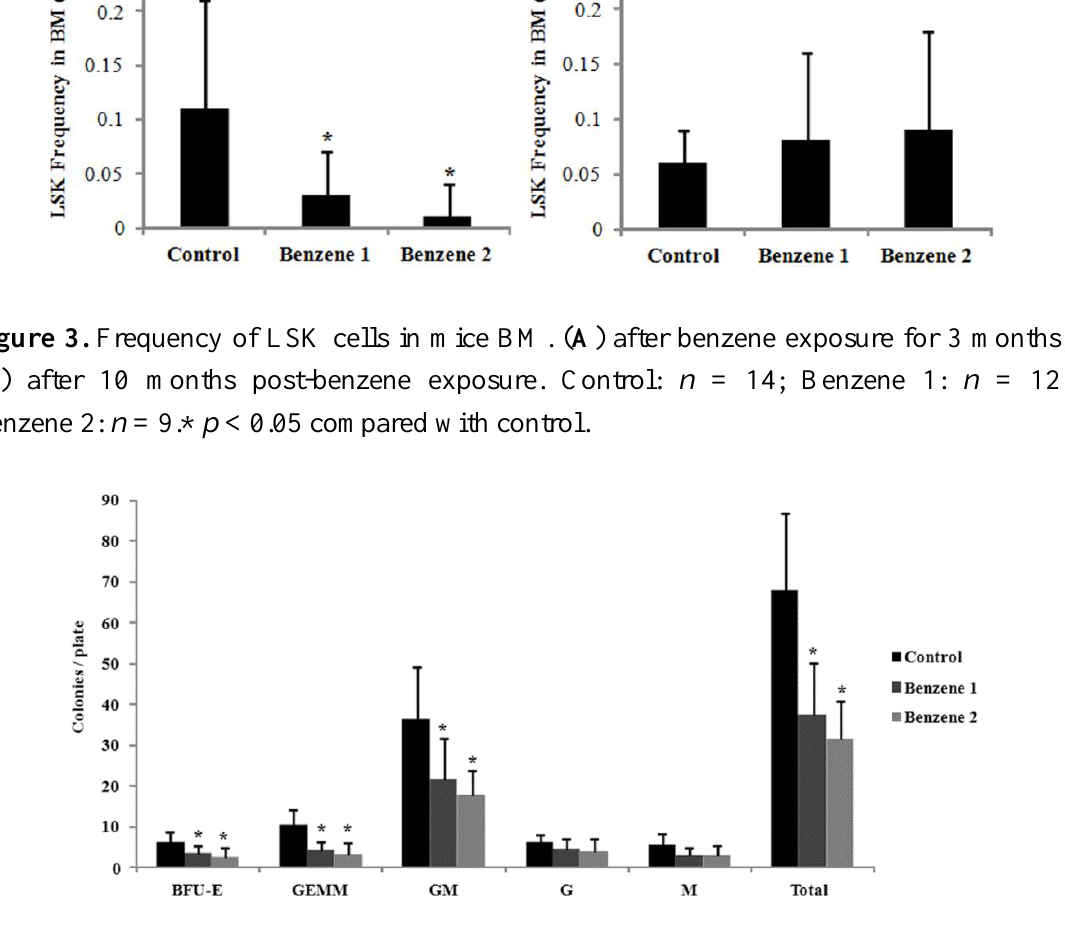
Figure 4. Colony-forming capability of mice after 10 months post-benzene exposure. * p < 0.05 compared with